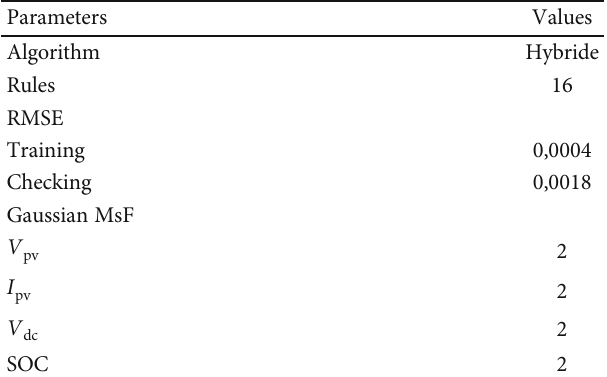
Table 2: ANFIS learning parameters.